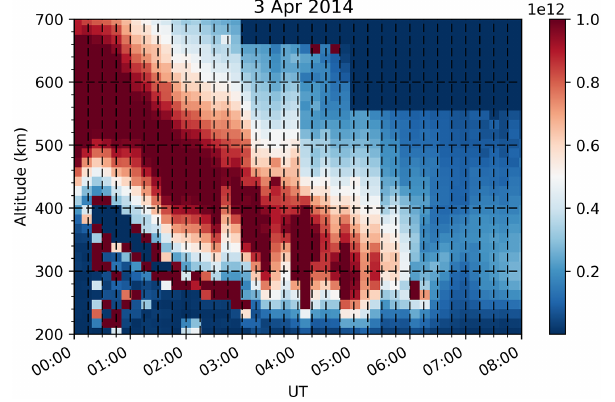
Figure 3. A range–time–intensity (RTI) plot from 3 April 2014 showing electron density as a function of altitude and Universal Time. The highest density region that moves down through the night is the F layer. Regions of low density associated with depletions are seen beginning just before